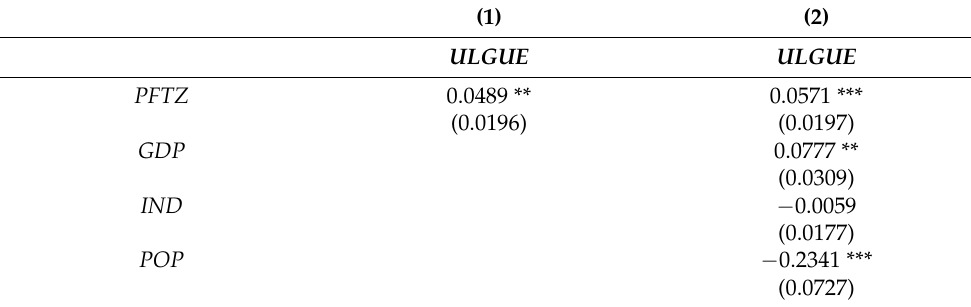
Table 3. Basic Table 3. Basic regression.